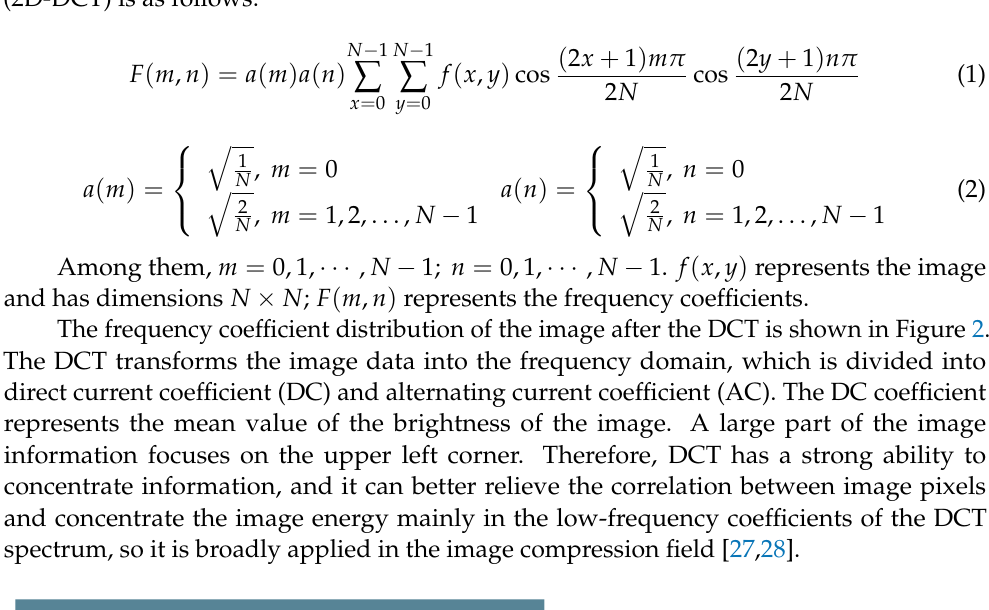
Figure 3. The result of multi-level DCT.